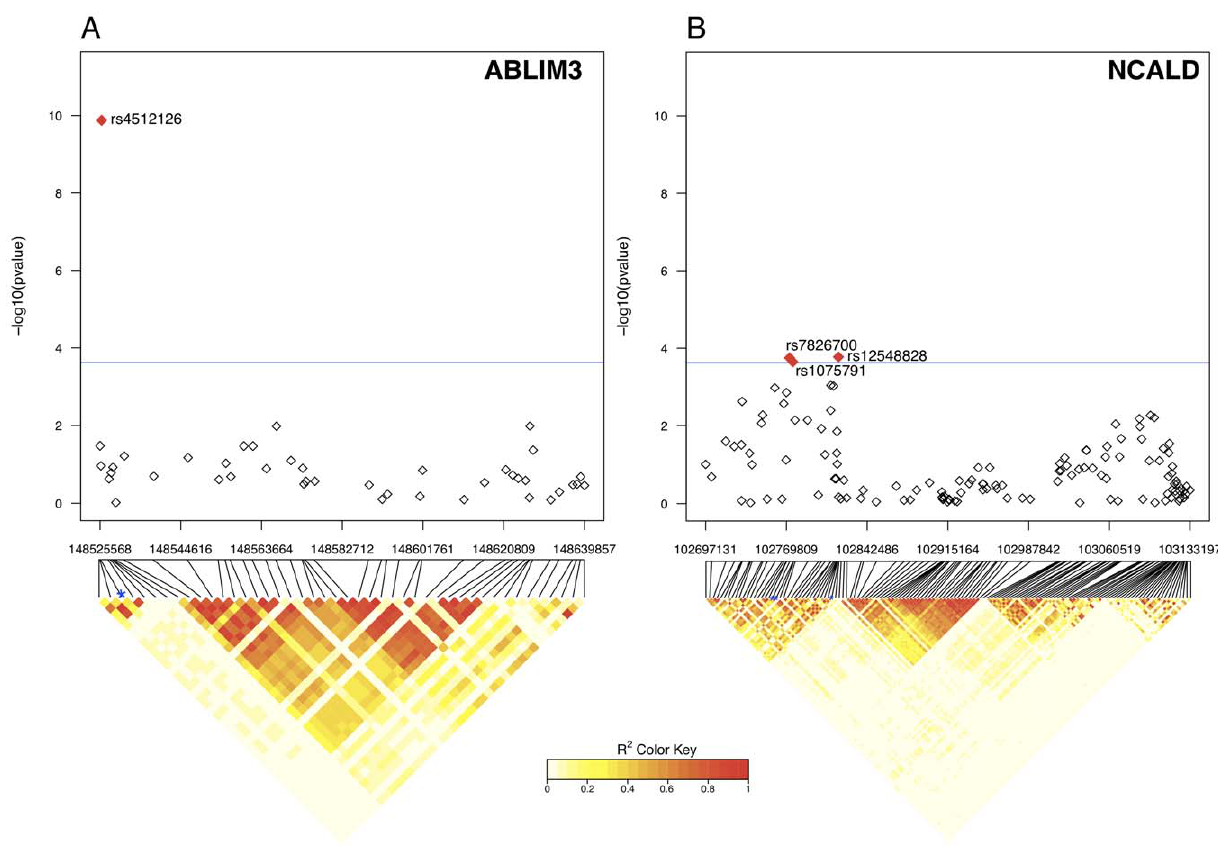
Figure 3. Manhattan plots and linkage disequilibrium heatmaps for ABLIM3 and NCALD . Log10 transformed correlation association p- values with pain cold threshold for 43 and 132 SNPs located in the ABLIM3 (A) and NCALD (B) genes regions, respectively. The x-axis represents the SNPs chromosomal physical location scale. The bottom heatmap represents linkage disequilibrium (LD) pairwise r 2 based on the genotyped twin cohort. Blue star indicates polymorphisms found to be significantly associated with pain cold threshold.